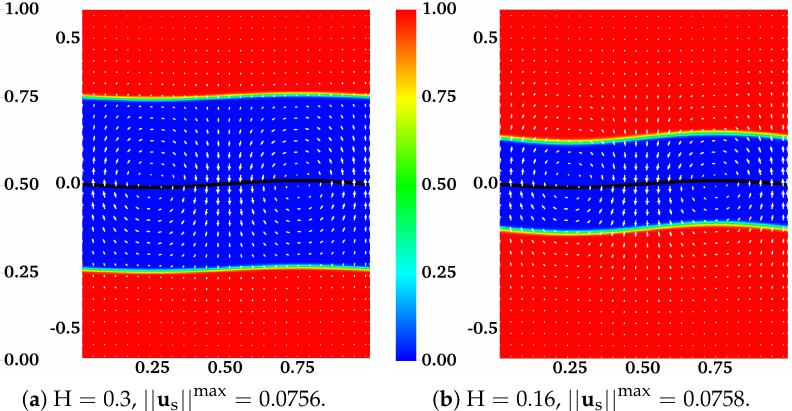
Figure 4. Distribution of network volume fraction θ n and fluid velocity u s at t = 0.5 for different H. All vectors have the same scale. The viscosity ratio between the two fluids is β = 0.5.